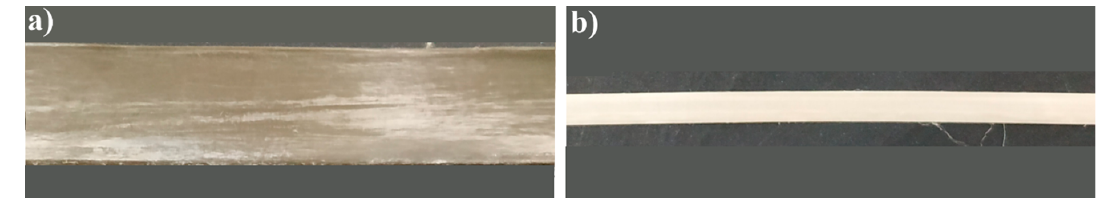
Figure 7. UHMWPE films form before ( a ) and after ( b ) drawing process.